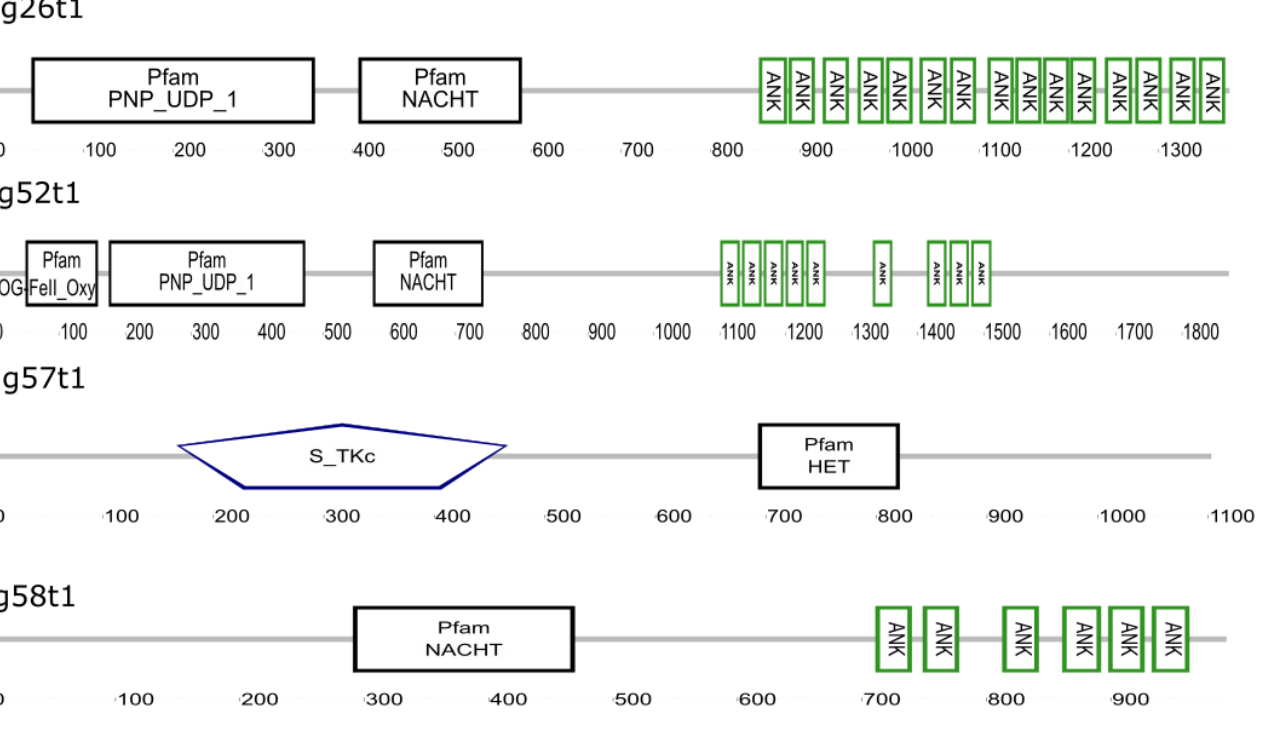
Figure 2. Architecture of proteins potentially involved in heterokaryon incompatibility. Black rectangles—protein domains related to heterokaryon incompatibility. Green rectangles—ankyrin domain repeats. Blue polygon—protein kinases